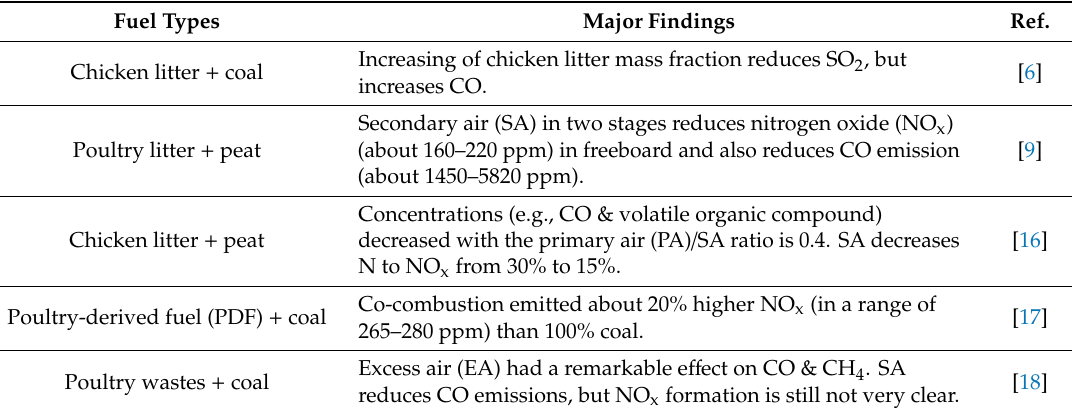
Table 1. Summary of co-combustion studies of poultry litter and